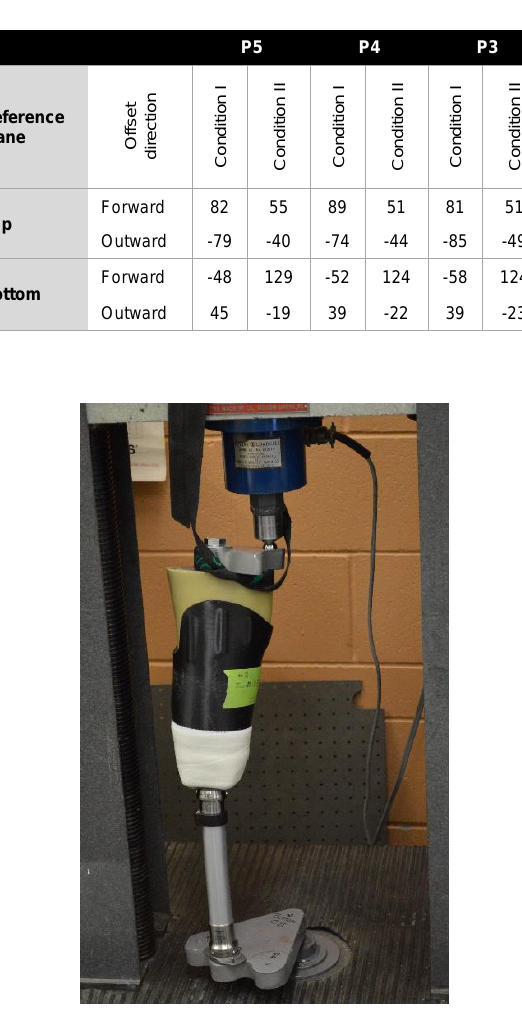
FIGURE 3. The experimental set up consisting of the socket and pylon held by a custom-made jig in the Tinius Olsen universal testing